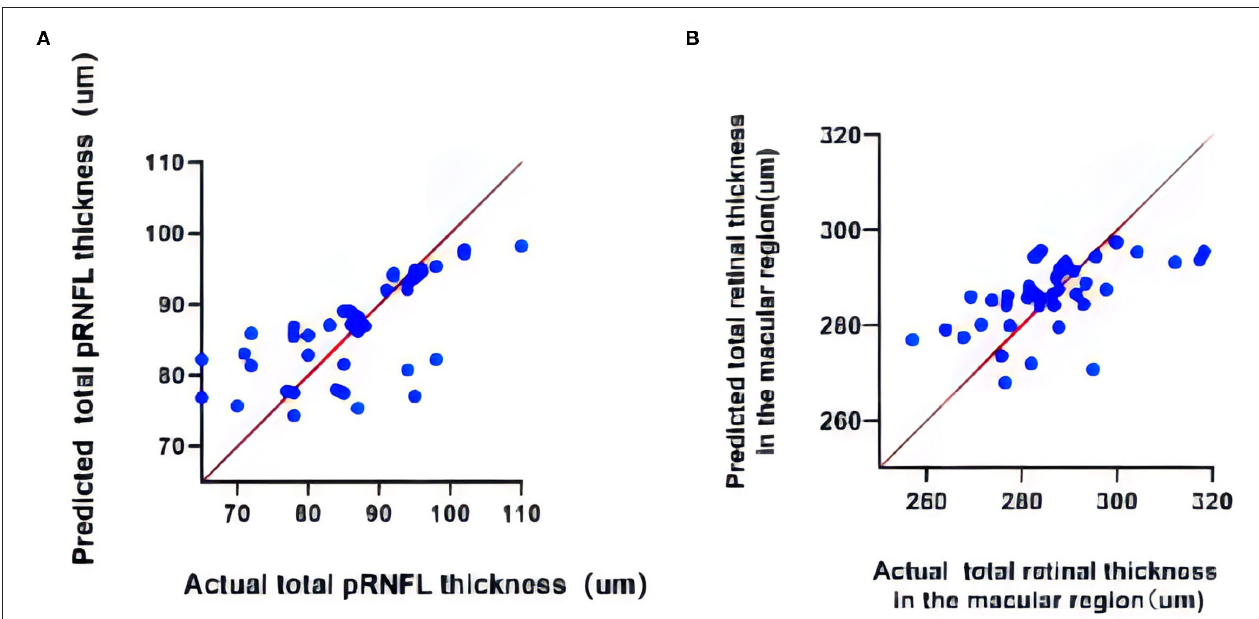
FIGURE 8 | (A) The multivariable regression analysis of total pRNFL thickness. (B) The multivariable regression analysis of total retinal thickness in the macular region.